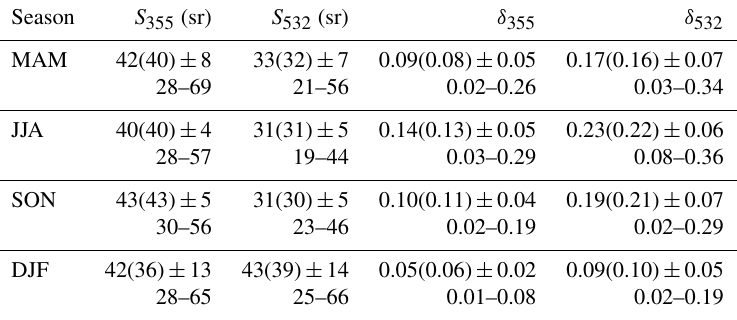
Table 3. Seasonal mean(median) values ± SD of lidar ratios ( S 355 , S 532 ) and particle linear depolarization ratio ( δ 355 , δ 532 ) at 355 and 532nm wavelength. The range of the values from minimum to maximum is given in the second row.